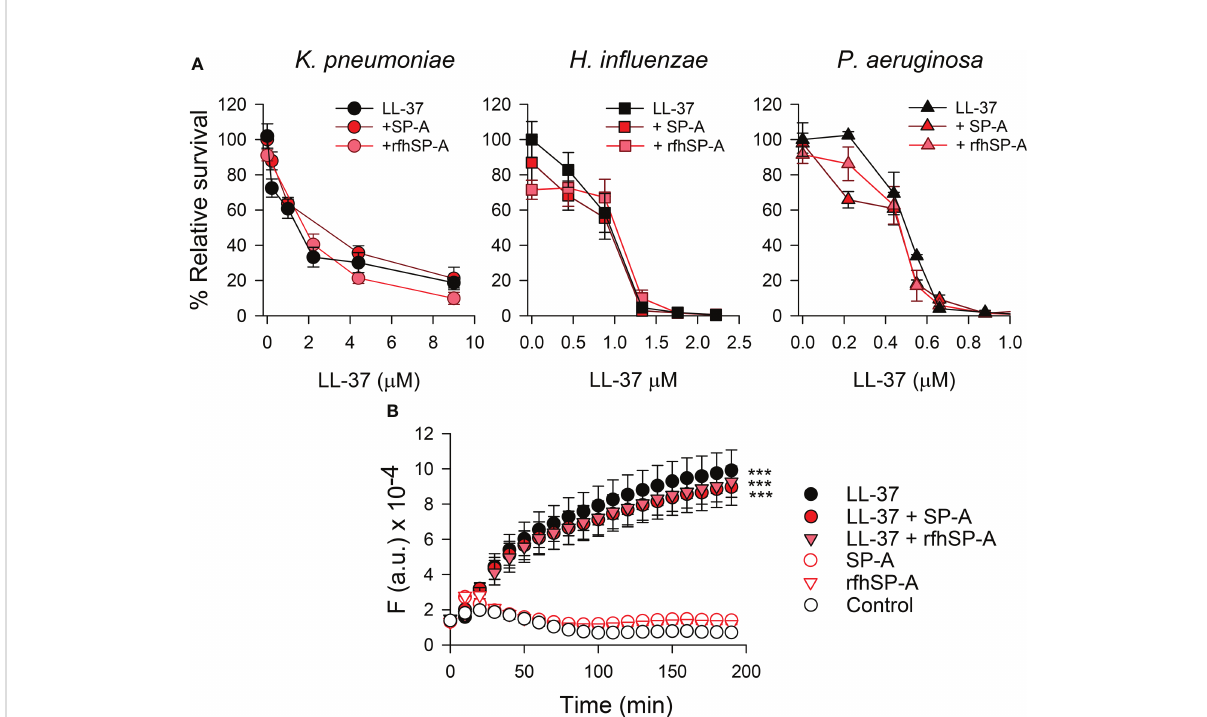
FIGURE 7 (A) Antimicrobial activity of LL-37 against K pneumoniae , non-typable H in fl uenzae , and P. aeruginosa , in the presence and absence of SP-A or rfhSP-A. 10 5 CFUs/ml of K pneumoniae K2, NTHi, and P. aeruginosa O1 were incubated with different concentrations of LL-37 in the absence and presence of SP-A and rfhSP-A in PBS (pH 7.4), for 1 h at 37°C. The fi nal concentration of SP-A was within the ranges found in the alveolar fl uid of human lungs: 0.11 µM for the K pneumoniae assay, 0.025 µM for the NTHi assay, and 0.012 µM for the P. aeruginosa assay. These concentrations were used to maintain a similar molar ratio between LL-37 and SP-A in each killing assay. Regarding rfhSP-A, the fi nal molar concentration in each assay was six times higher than that of SP-A (0.7 µM, 0.15 µM, and 0.075 µM, respectively) since native SP-A is composed of 6 trimeric units. Bacteria were then plated on LB agar ( K. pneumoniae and PAO1) or sBHI agar (NTHi) for CFU counting. Results are shown as a percentage of relative survival compared to untreated bacteria. Data are means ± S.E.M. of three independent experiments, with three biological replicates. (B) Membrane integrity of Gram-negative bacteria. 10 7 CFU/ml of K pneumoniae were incubated with 2.2 µM LL-37 and/or (0.075 µM) SP-A and (0.4 µM) rfhSP-A in the presence of Sytox Green. The change in the fl uorescence of the dye was recorded as a function